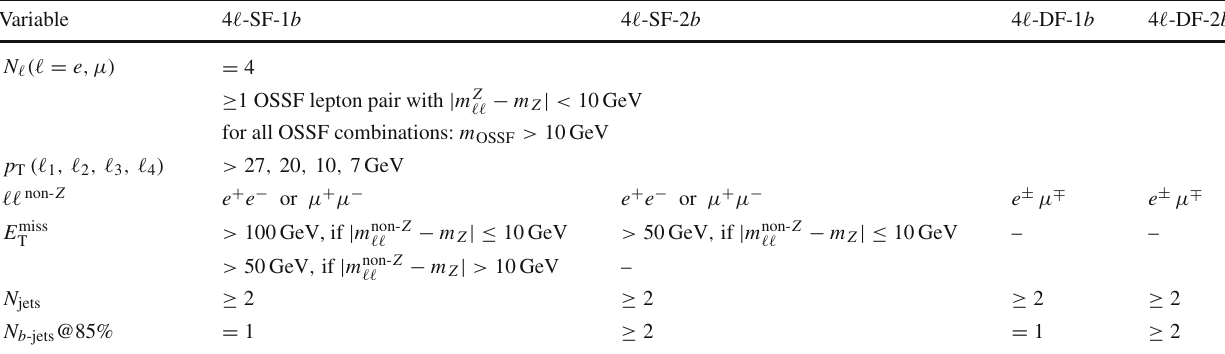
Table 2 The definitions of the four tetraleptonsignal regions. The regions are defined to target different b -jet multiplicitiesand flavour combinations of the non- Z leptons ( (cid:11)(cid:11) non- Z